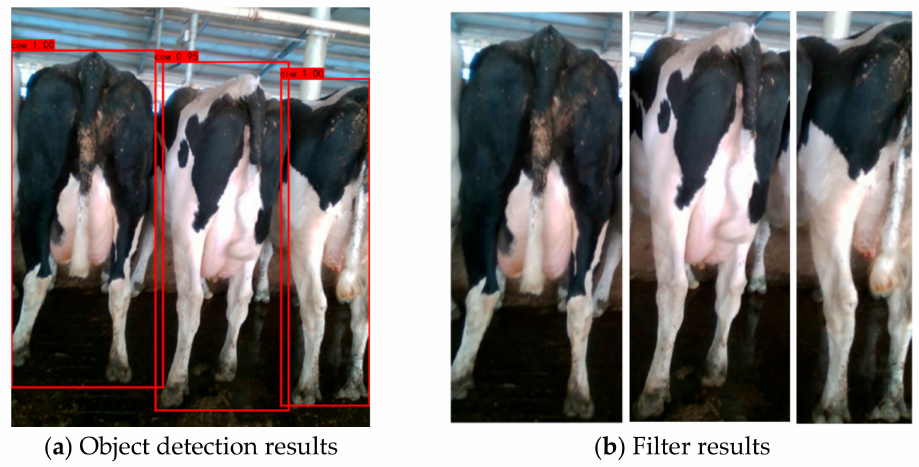
Figure 4. An example of rump object detection.